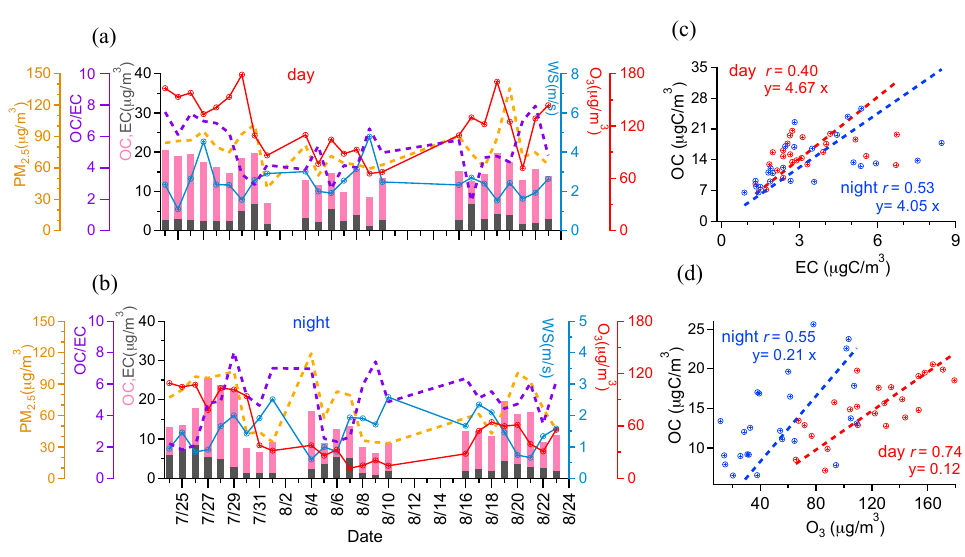
Figure 2. Time series of PM 2.5 , OC, EC, OC/EC (left y -axis), wind speed (WS), and O 3 (right y -axis) during daytime ( a ) and nighttime ( b ), respectively; scatter plots of ( c ) OC vs. EC, and ( d ) OC vs. O 3 (red for daytime and blue for nighttime).